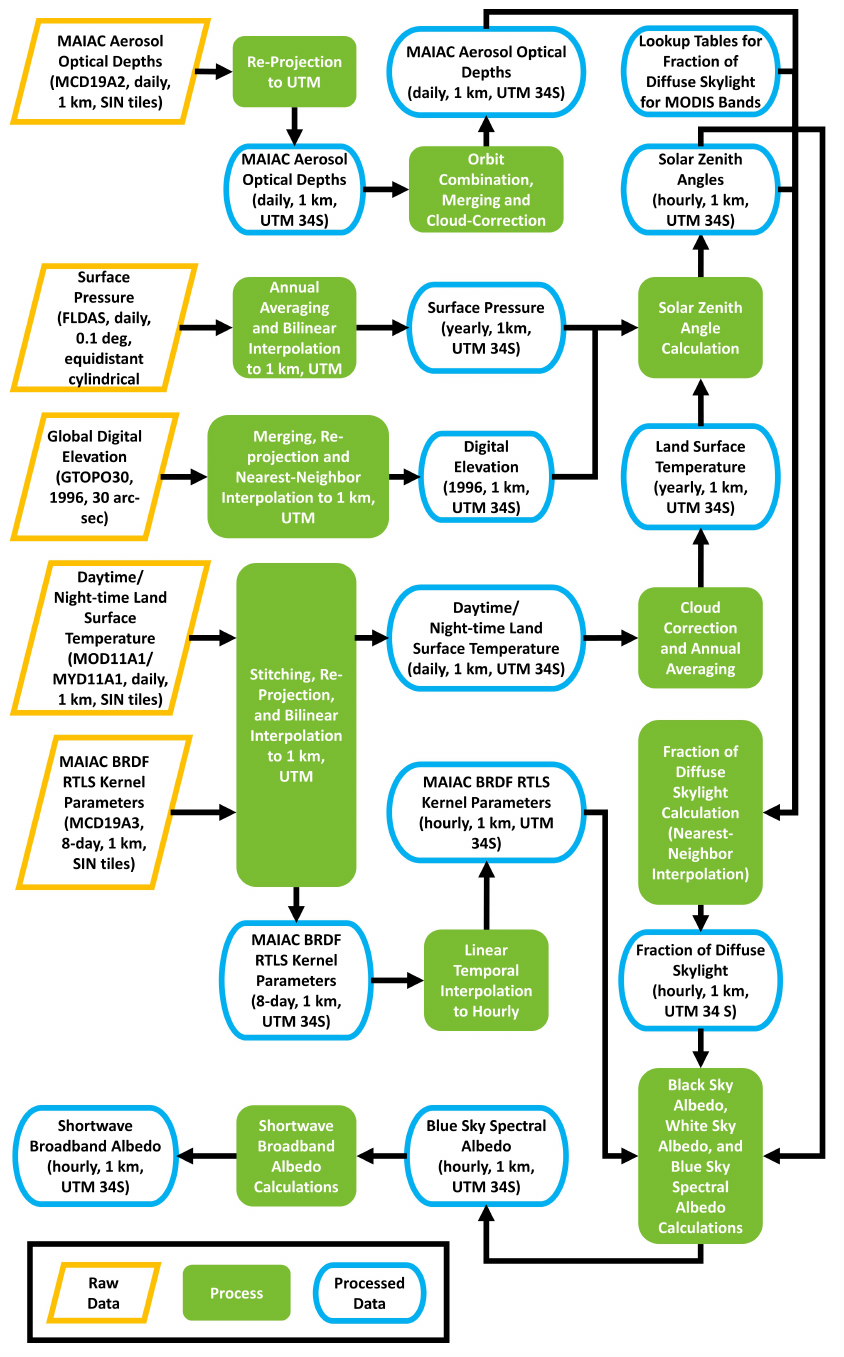
Figure 7. Surface albedo data processing and calculations flowchart. MAIAC, Multi-Angle Implemen- tation of Atmospheric Correction. SIN, MODIS SINusoidal projection. UTM, Universal Transverse Mercator projection. FLDAS, Famine Early Warning Systems NETwork (FEWS NET) Land Data Assimilation System. GTOPO30, Global 30-Arc Second Elevation. BRDF, Bi-directional Reflectance Distribution Function. RTLS, Ross-Thick